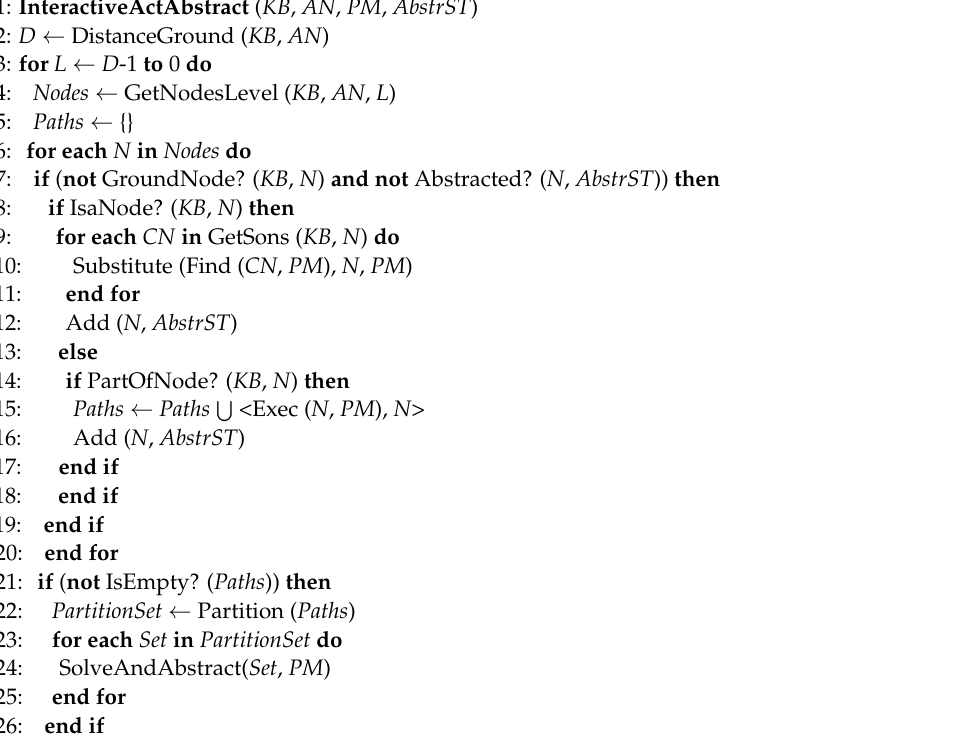
Algorithm 3: pseudocode of the interactive activity-based abstraction